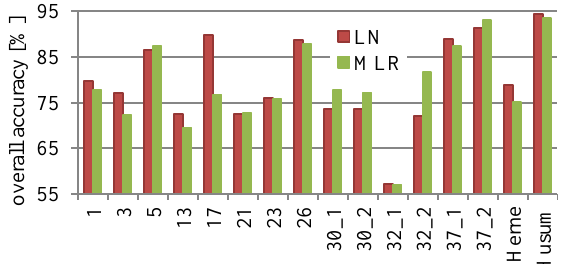
Figure 8. Overall accuracy for all tests only taking into account the pixels affected by a change.